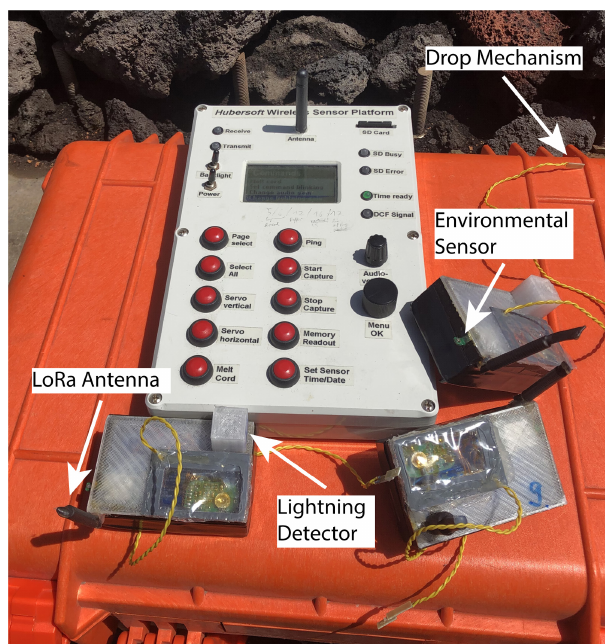
Figure 1: Base station and three sensors including drop mecha- nism ready for deployment. The base station is equipped with a primary antenna for the communication with the sensors and a secondary internal antenna to receive the DCF77 time signal. Downloaded data is stored on exchangeable SD card. Sensors are equipped with a primary monopole antenna for the LoRa communication and a secondary antenna for the lightning de- tection resonant circuit. The environmental BME 280 sensor is located on the outside of the housing, while the microphone is inside the housing protected by a membrane still allowing the detection of acoustic signals. The yellow chord is the drop-off mechanism. A bright LED is located below the membrane for a visual check of signal